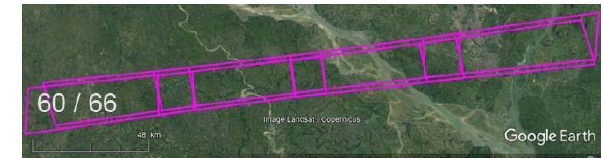
Figure 16. Colour coded change of CORONA DSM by correction with TDM90